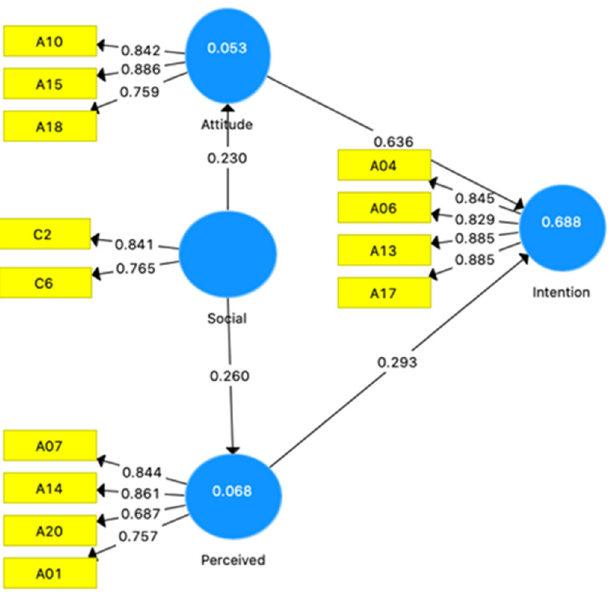
Figure 3. PLS Model for model 2 (men).